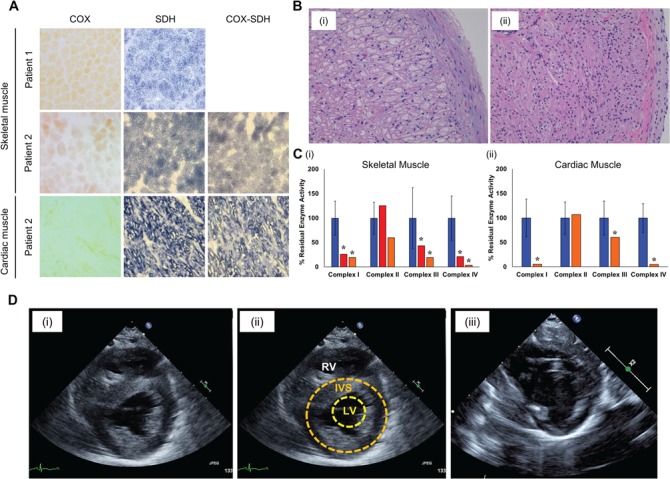
Histochemical and biochemical studies of AARS2 patient skeletal and cardiac muscle. (A) Diagnostic skeletal and cardiac muscle were subjected to COX, SDH and sequential COX-SDH histochemical reactions. Skeletal muscle from Patient 1 was not subjected to sequential COX-SDH histochemistry. (B) Photomicrograph of (i) Patient 2 cardiac muscle sampled at autopsy and (ii) healthy heart of a child of similar age. (C) Measurement of mitochondrial OXPHOS activities (CI-CV) normalized to CS in skeletal (Patient 1 and 2) and cardiac muscle (Patient 2), as a percentage of residual controls. Controls are denoted in blue, Patient 1 in red and Patient 2 in orange. Decreased OXPHOS activities are denoted by asterisks (‘*’). (D) Echocardiographic images in the parasternal short axis view of Patient 2’s heart (i and ii; annotated in panel ii) and the normal heart of a child approximately the same age (iii). The patient’s heart demonstrates severe concentric hypertrophy of the left ventricle (LV) involving both the interventricular septum (IVS) and the posterior wall. Also identified is the right ventricle (RV).